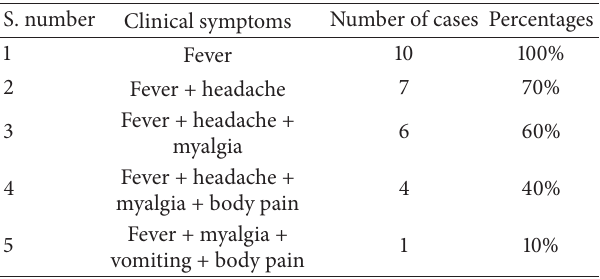
Table 3: Clinical symptoms among patients positive for leptospiral antibodies.